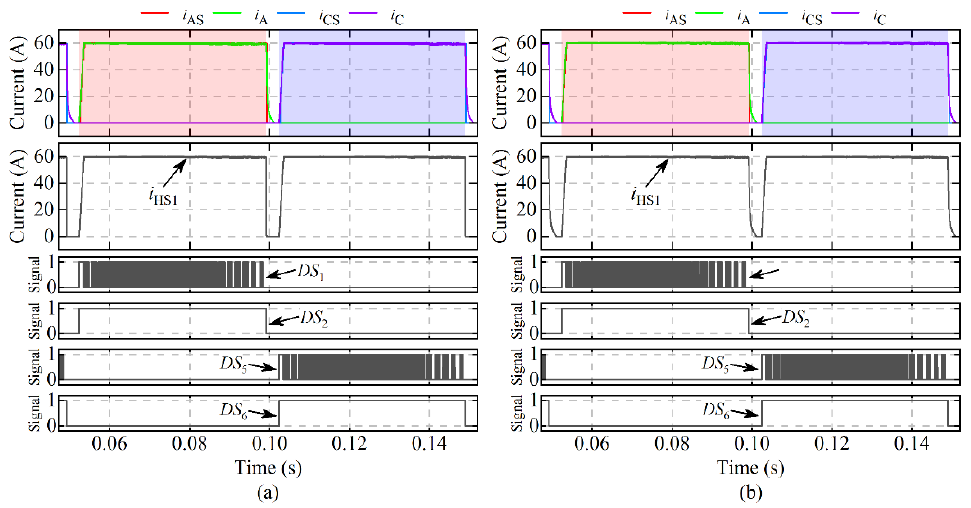
Figure 13. Simulation waveforms at 100 rpm ( i * = 60A). ( a ) With the proposed N p /2 sensors-based current detection scheme. ( b ) With the baseline scheme.